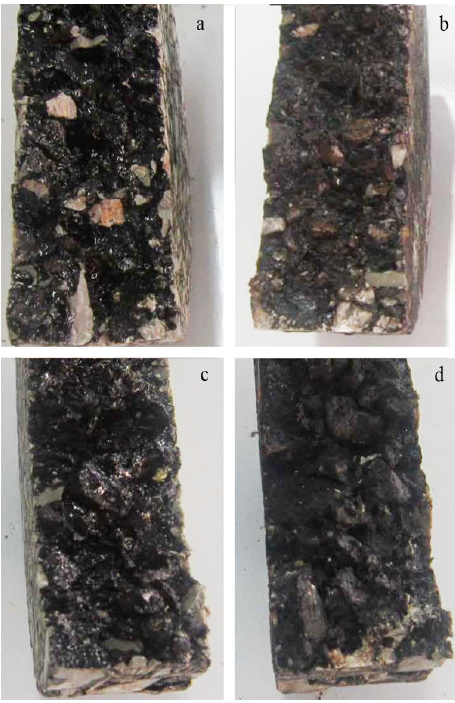
Fig. 9. Broken faces of the split samples: a) for dry limestone sample at 4.4 ºC; b) for moisture conditioned limestone sample at 4.4 ºC; c) for dry limestone sample at 21.1 ºC; d) for moisture conditioned limestone sample at 21.1 ºC